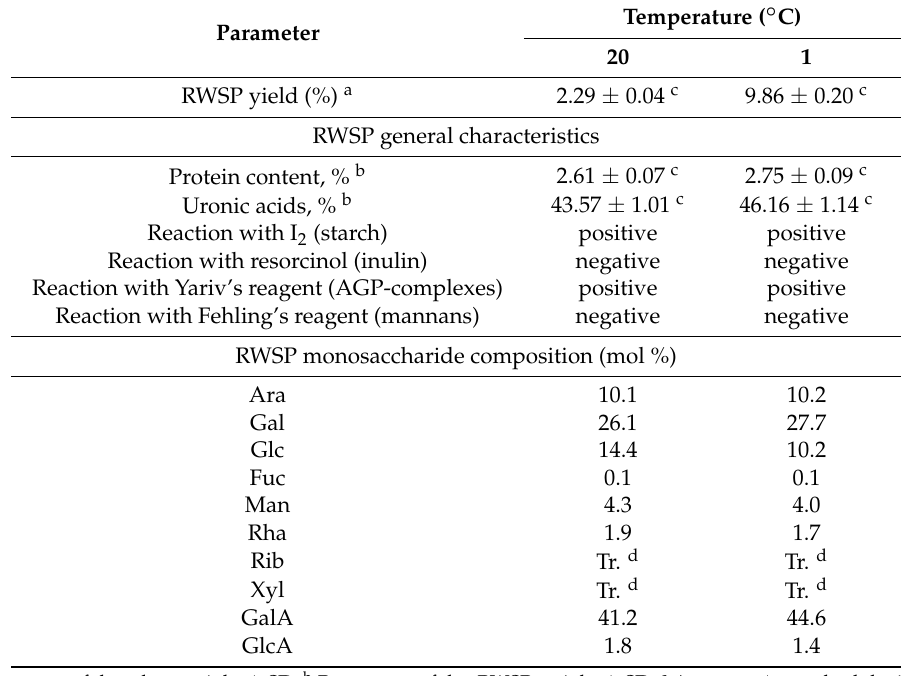
Table 7. Yield of raw water soluble polysaccharide (RWSP) of D. palmatum herb under different temperatures of cultivation, their general characteristics and monosaccharide